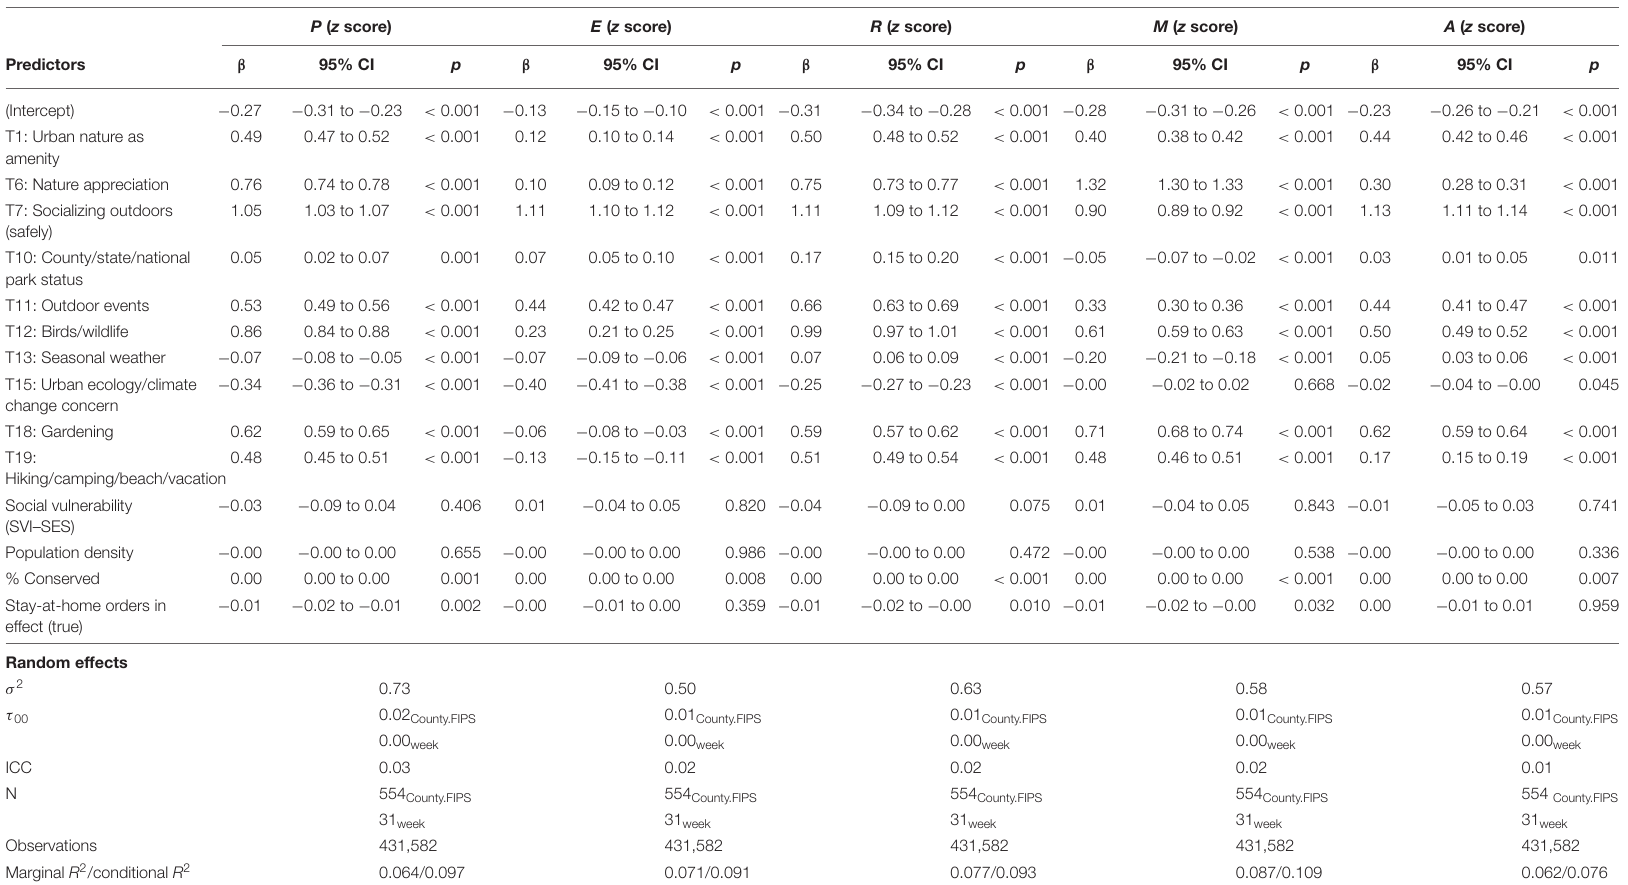
TABLE 5 | Mixed-effects model results for positive subfactors (P—positive emotion, E—engagement, R—positive relationships, M—meaning, and A—accomplishments/achievements) of PERMA for 2020-only tweets, reporting 95% confidence intervals